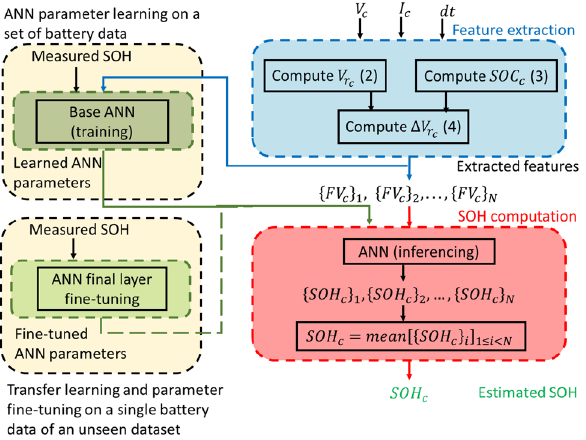
Figure 10. Flow chart of the